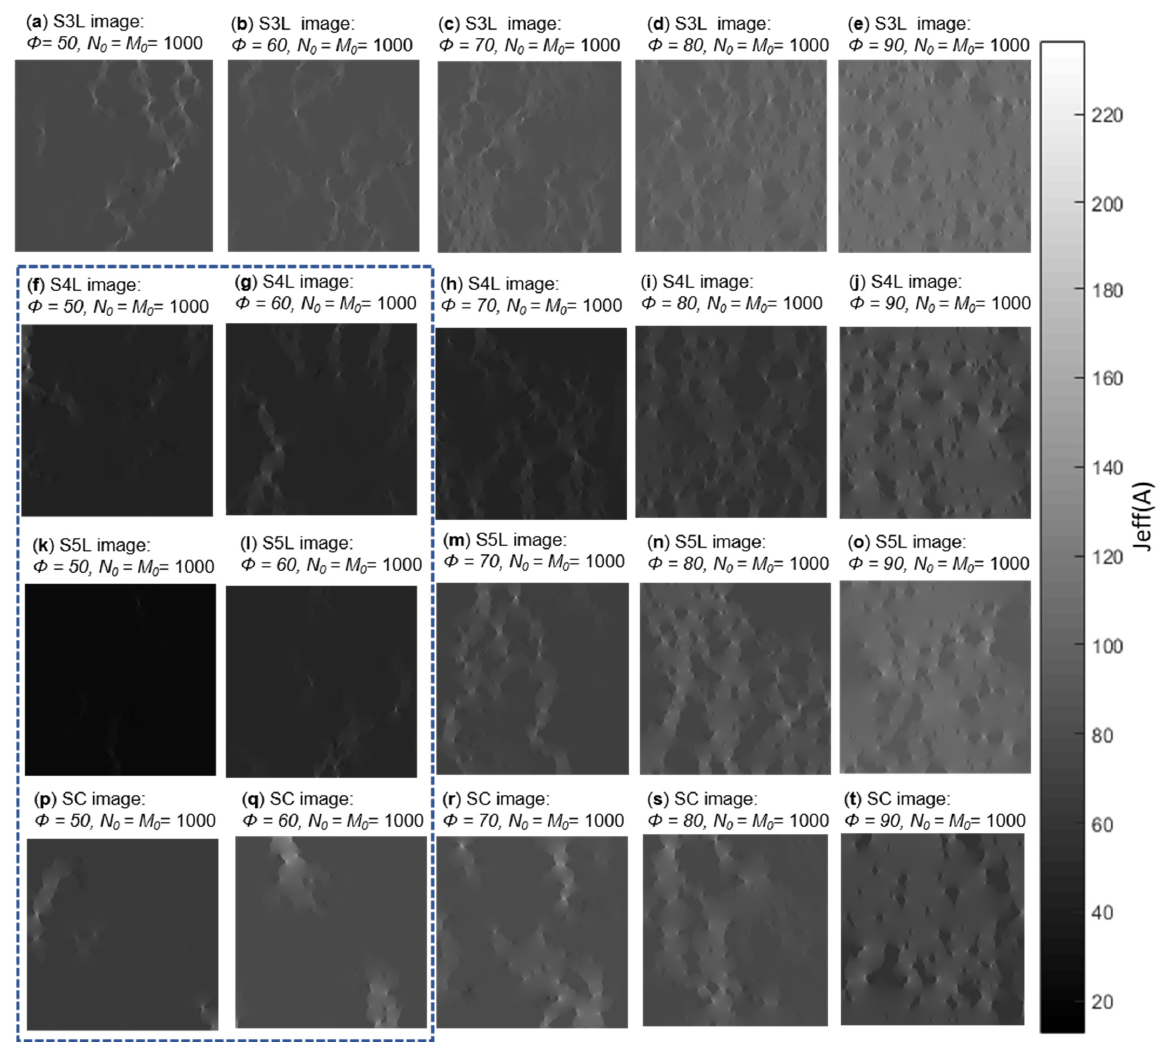
Figure 12. Local current distribution J ef f for the agglomerate phase of Figure 7 in a surface fraction range from 50% to 90%. ( a – e ) show local current distribution results for S3L images, ( f – j ) show local current distribution results for S4L images, ( k – o ) show local current distribution results for S5L images and ( p – t ) show local current distribution results for SC images. Images en-closed by the dotted line do not have a connection between pixels or cur-rent distribution between their